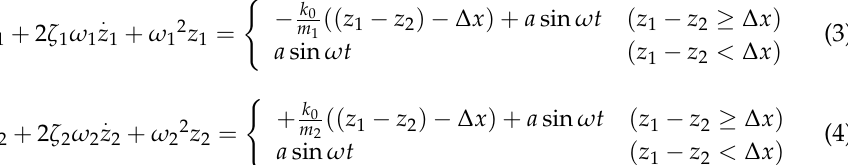
− z ≥ ∆ x and ( b ) z 1 2